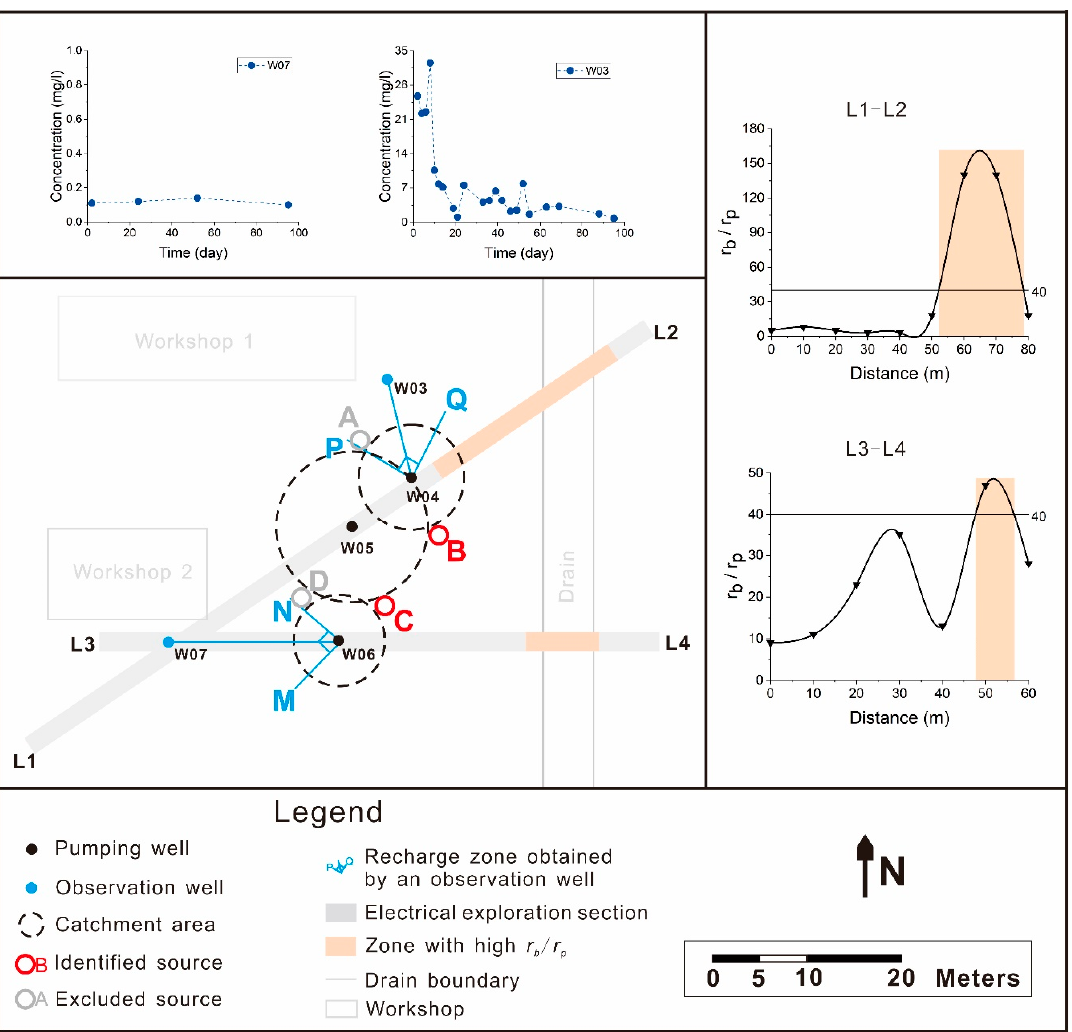
Figure 5. Source position identified by the circle intersections. The observation well monitoring results assist in determination of the source zone. The source identification method was compared with the results of electrical prospecting.